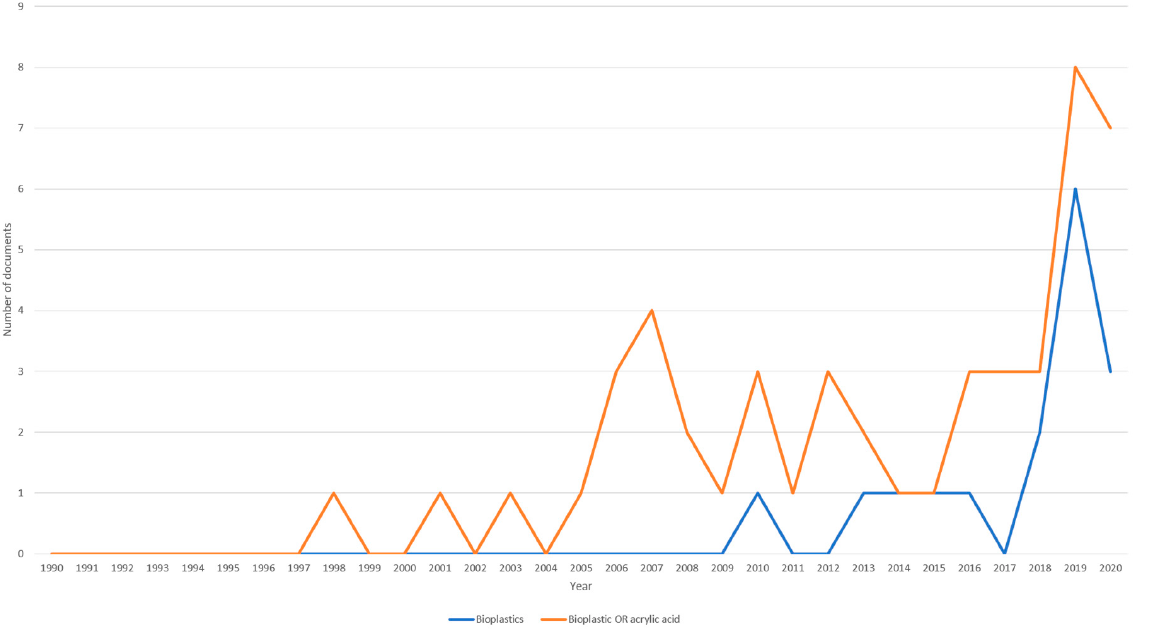
Figure 4. Documents per year for ‘bioplastics or bio-plastics or acrylic acid’ and ‘bioplastics or bio-plastics’ (Appendix B—iii).